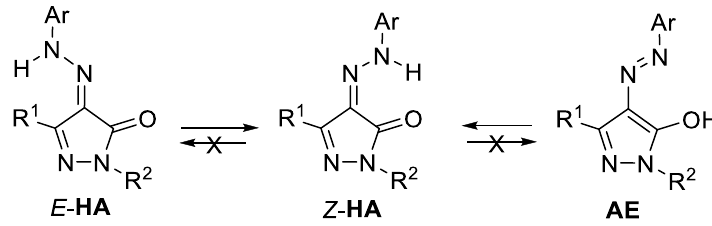
Table 2. In silico ADME prediction s of 4-AHPs 5 – 9